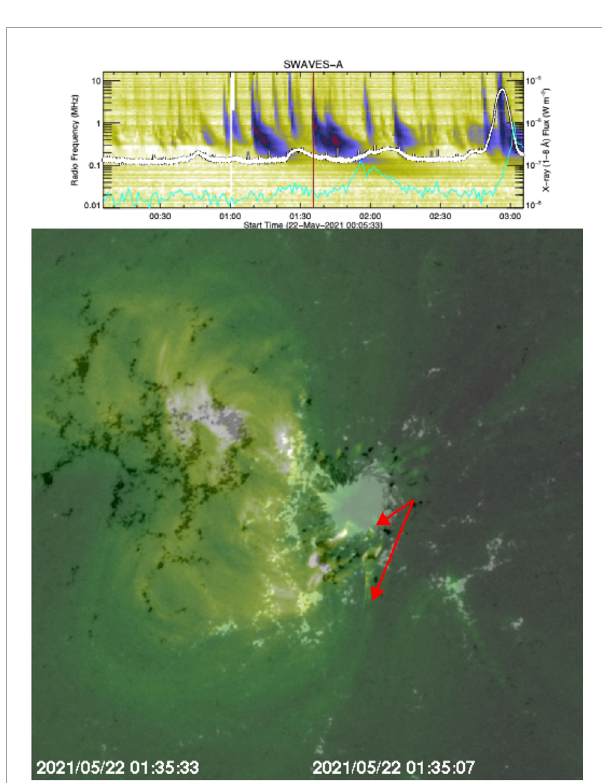
FIGURE 6 Snapshot from a movie of AIA 211 Å images of AR 12824 on top of HMI line-of-sight magnetograms. The red arrows point to the footpoint and spire of the jet. The full-length movie is included as Supplementary Video S4